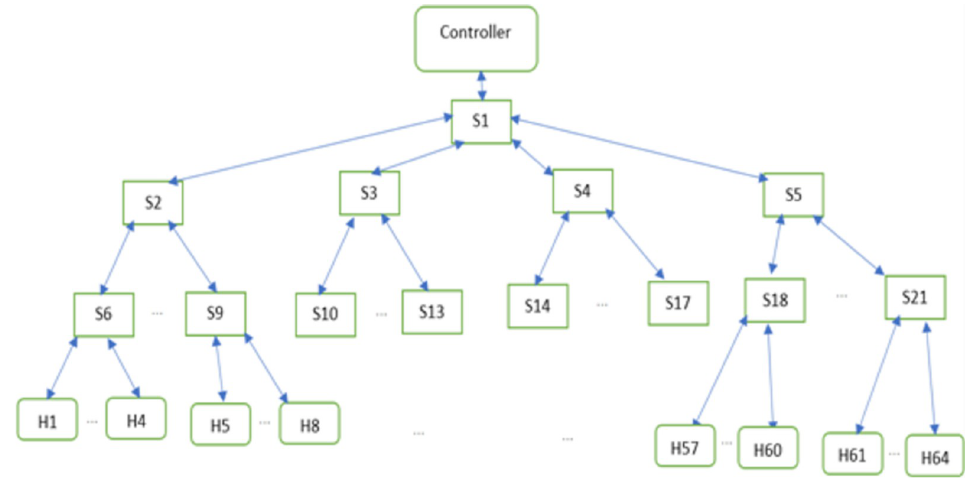
Fig 4. The network